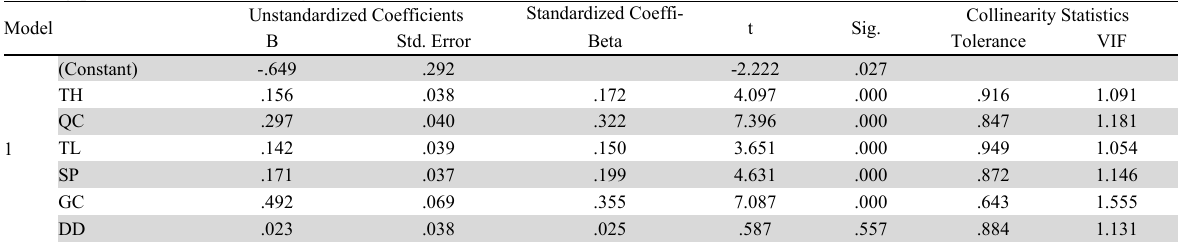
Table 7 Testing partial correlation of regression coefficient (1st time) Model